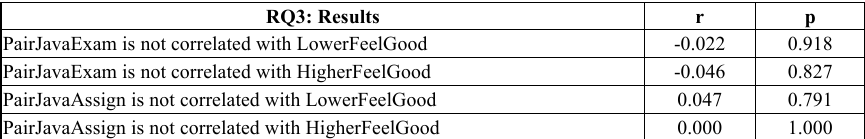
Table 8. Results summary of RQ3 (extended)